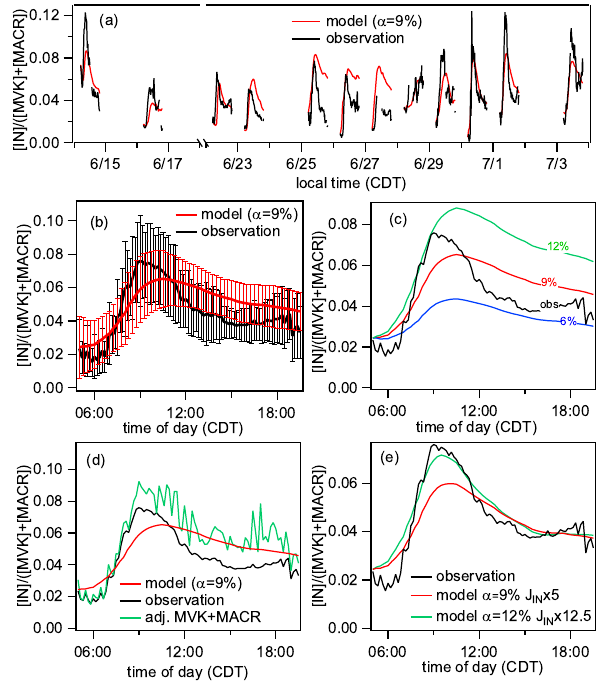
Figure 8. Simulated and observed [IN] / ([MVK] + [MACR]) ratio. (a) Results for each selected day. (b) Averaged results over the 12 days. The error bars represent day-to-day variation. (c) Sen- sitivity test with IN yield set as 6, 9, and 12% in the model. (d) MVK + MACR data were adjusted by subtracting observed IEPOX + ISOPOOH concentration from observed MVK + MACR concentration. (e) Results with enhanced IN photolysis